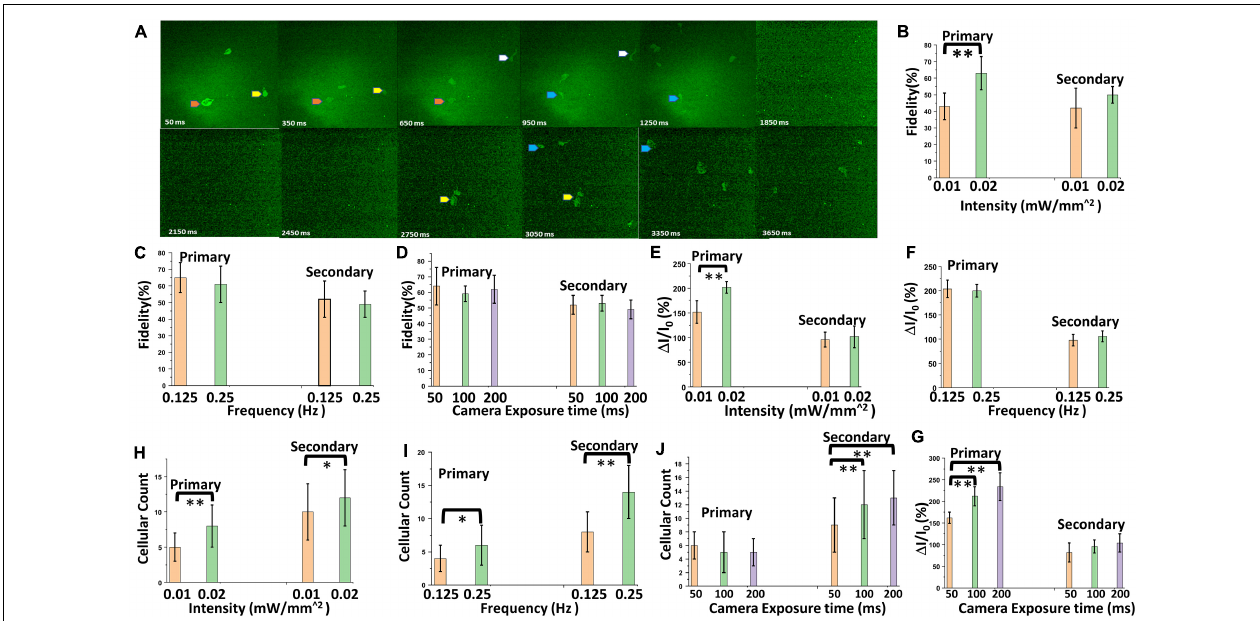
FIGURE 2 | Characterization of Ca 2 + bioluminescence in the bMCOII-sensitized visual cortex upon light stimulation. (A) Time-lapse images Ca 2 + bioluminescence of a bMCOII-sensitized cortical slice stimulated with light (10 µ W/mm 2 ). (B) Fidelity of activation of selected neurons. (C) Fractional increase in Ca 2 + bioluminescence intensity. (D) Number of active neurons, during primary and secondary response period as a function of light stimulation intensity. Variation in (E) fidelity. (F) Fractional increase in Ca 2 + bioluminescence intensity. (G) Number of active neurons with the frequency of light stimulation pulses. (H) Fidelity of activation of selected neurons. (I) Fractional increase in Ca 2 + bioluminescence intensity. (J) Number of active neurons as a function of camera exposure time. N = 70 neurons, 10 stimulations. Av. ± SD. * p < 0.05, ** p <